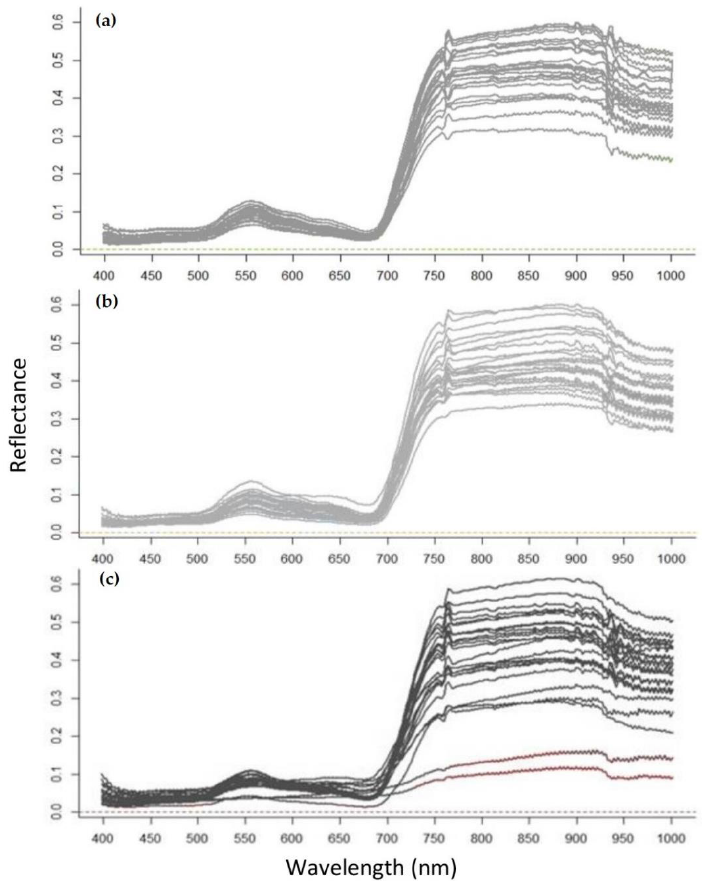
Figure 6. The mean spectral signatures of each sample tree used as training: healthy class ( a ), fresh damage ( b ), and old damage ( c ).